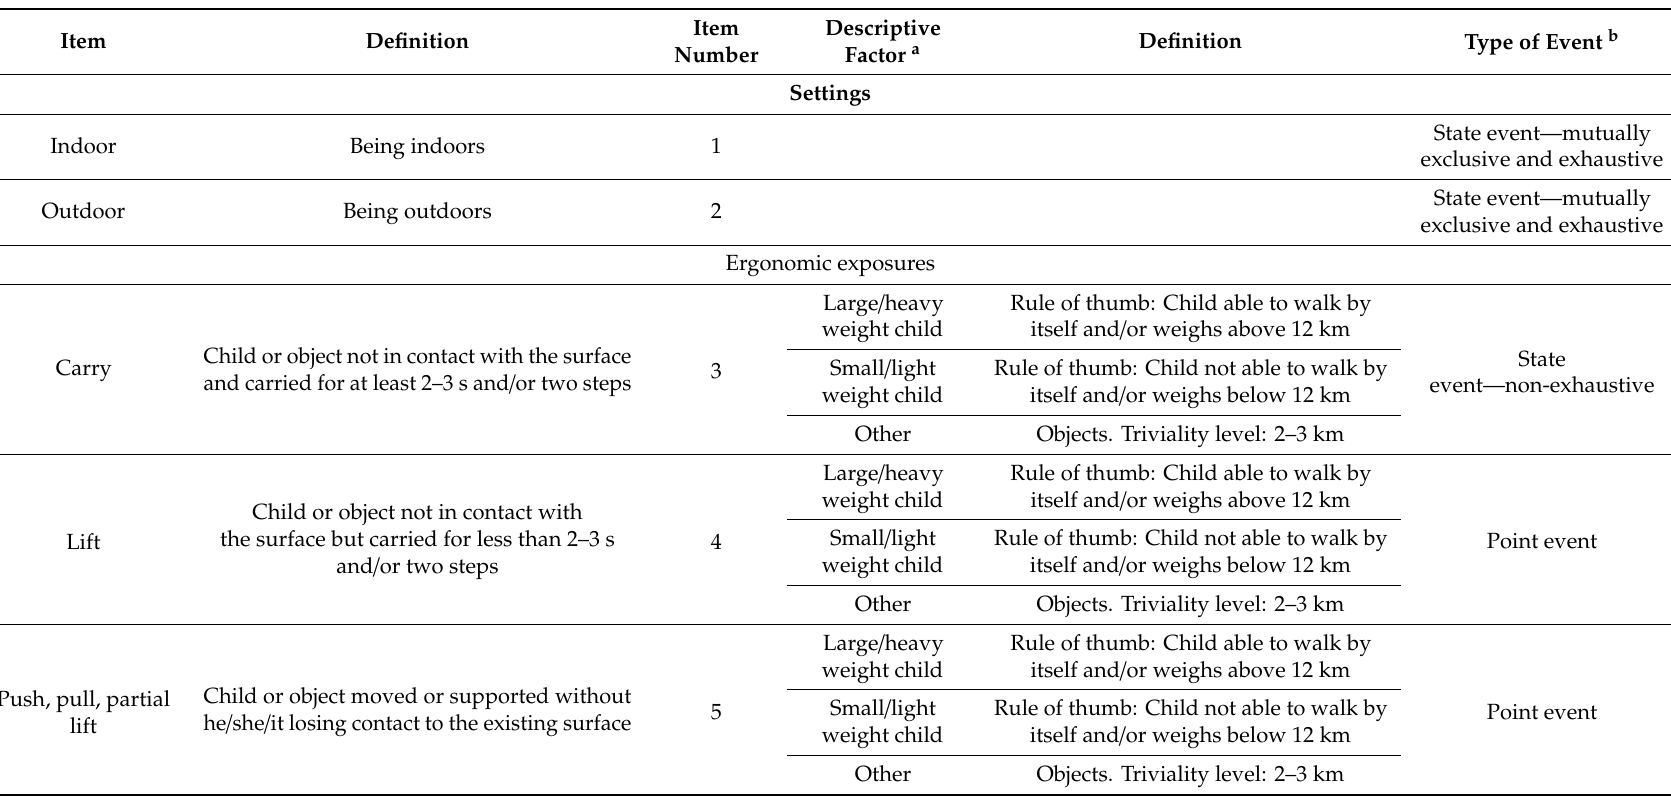
Table 1. Overview of the observaTion woRk demAnds Childcare worK (TRACK) observation instrument for assessing ergonomic work demands in childcare work. The instrument consists of 20 items in four categories. Six items contain descriptive factors as